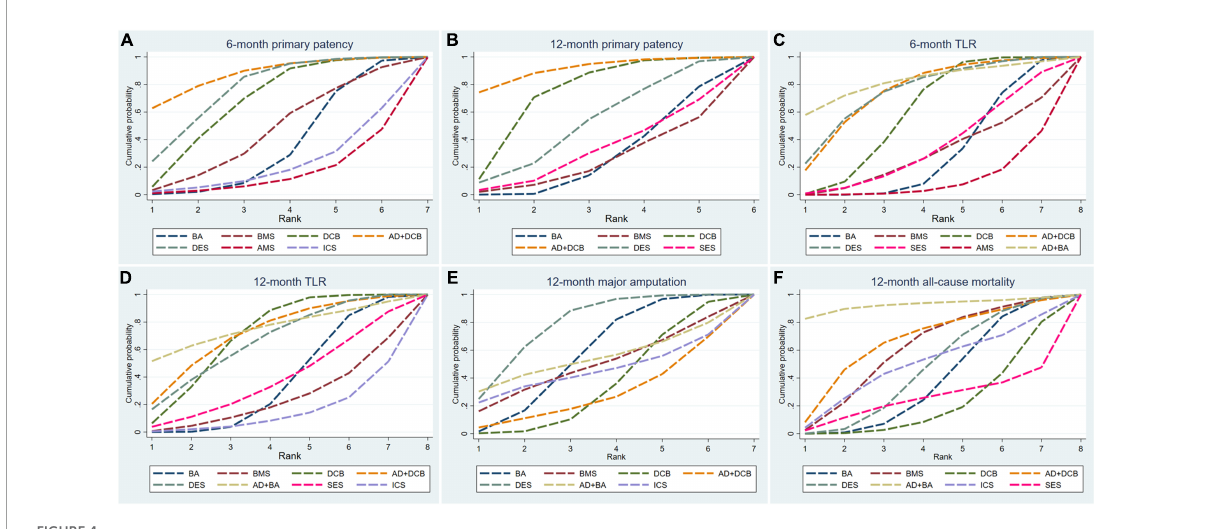
FIGURE4 Surface under the cumulative ranking curve (SUCRA) plots for all outcome measures. TLR, target lesion revascularization; BA, balloon angioplasty; DCB, drug-coated balloon; AD, atherectomy device; DES, drug-eluting stent; BMS, balloon-expandable bare metal stent; SES, self-expanding stent; AMS, absorbable metal stents; ICS, inorganics-coated stent. The first row is (A–C) , and the second row is (D–F) .